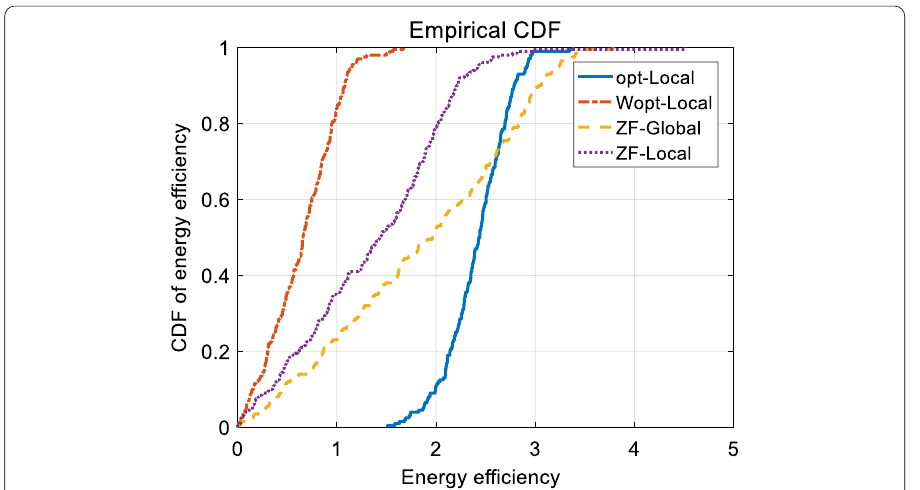
Fig. 10 Comparison of energy efficiency of using MRC (optimized and not optimized) and ZF (local processing [43] and global processing), α 2 =